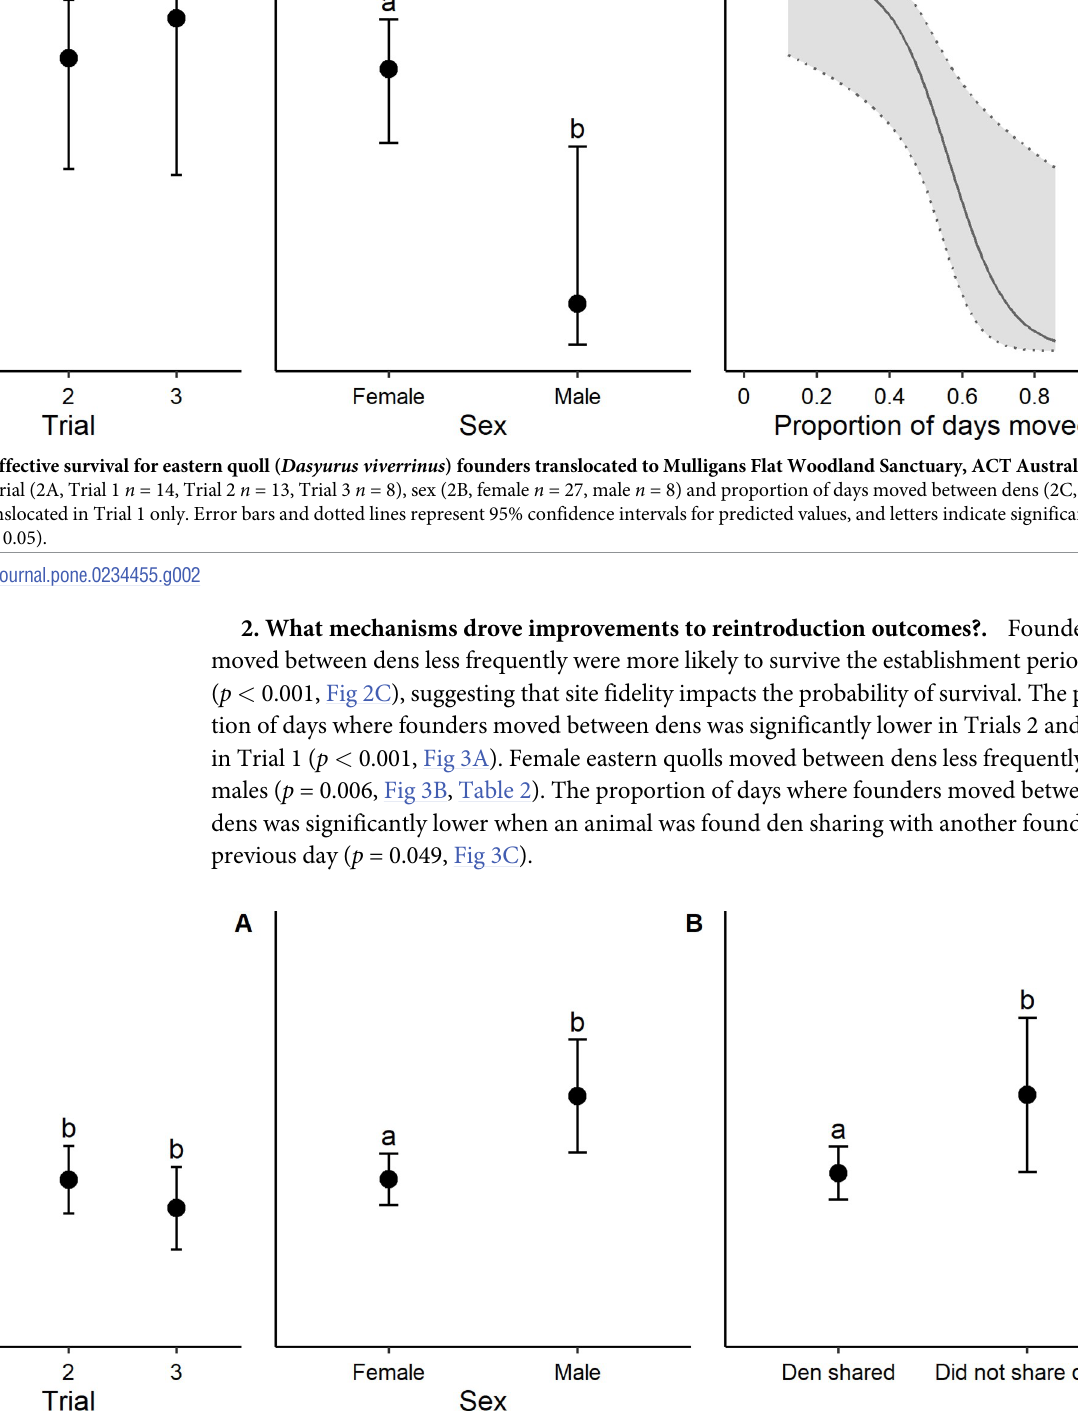
PLOS ONE | https://doi.org/10.1371/journal.pone.0234455 June 29,